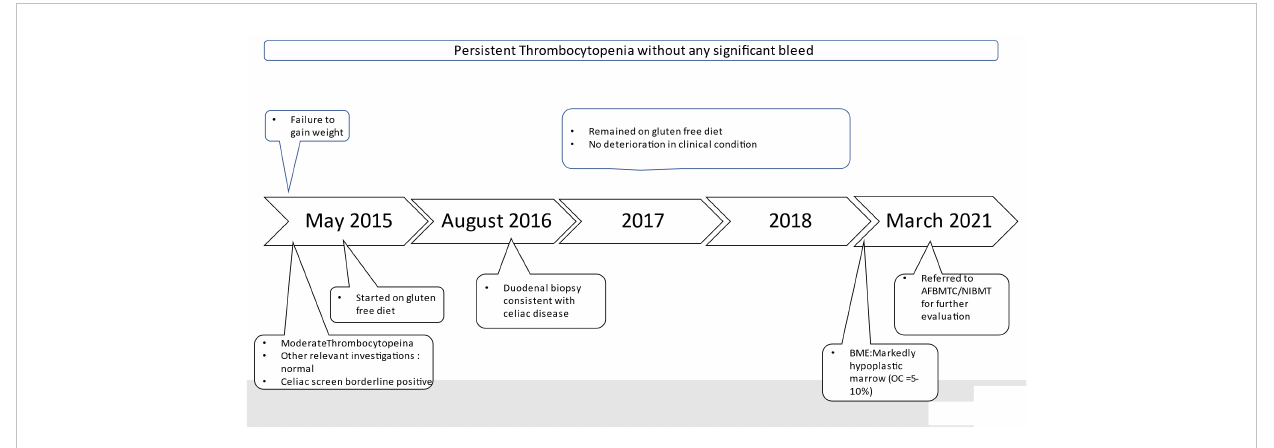
FIGURE 1 Summary of Clinical events before